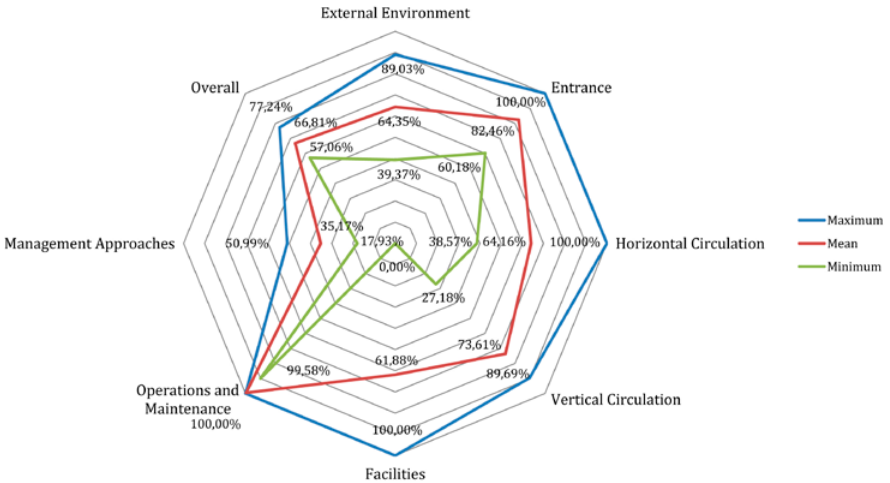
Fig. 5. Radar diagram showing the percentage of VIIS categories scored in the sampled